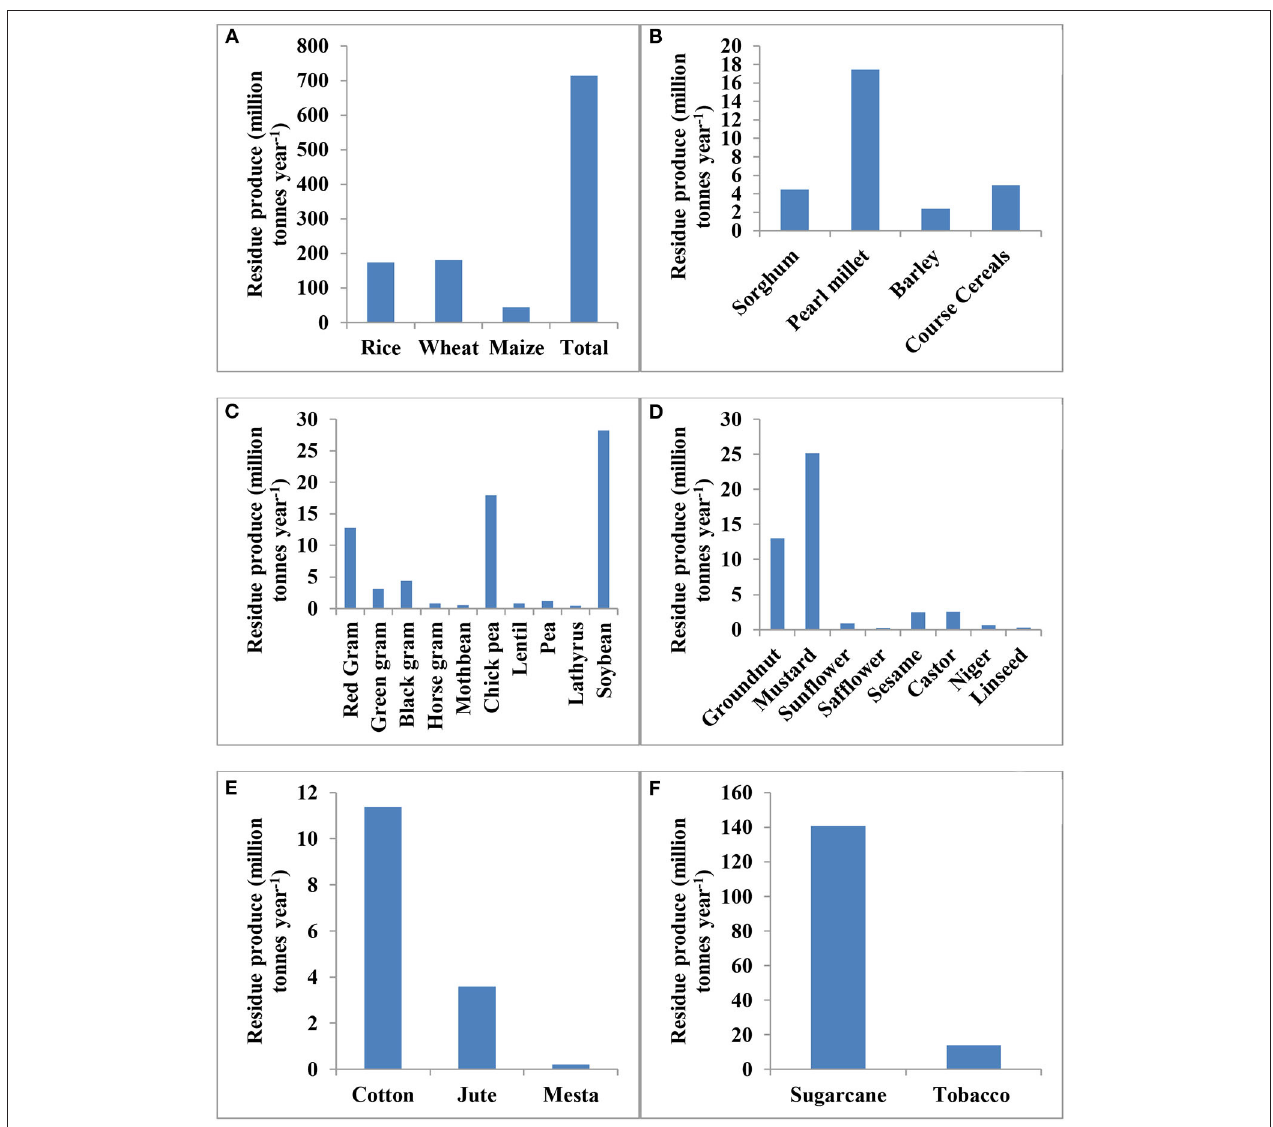
FIGURE 1 | Residue production from different crops in India (A–F) (Anonymous,